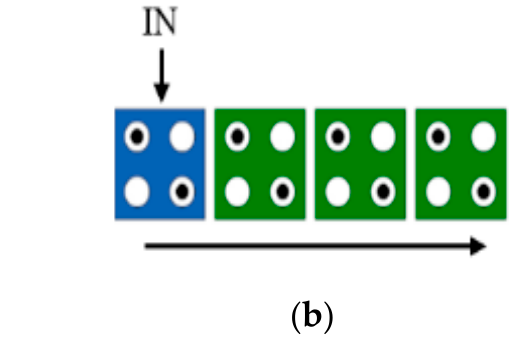
Figure 1. QCA basic concept: ( a ) two possible polarizations; ( b ) wiring.